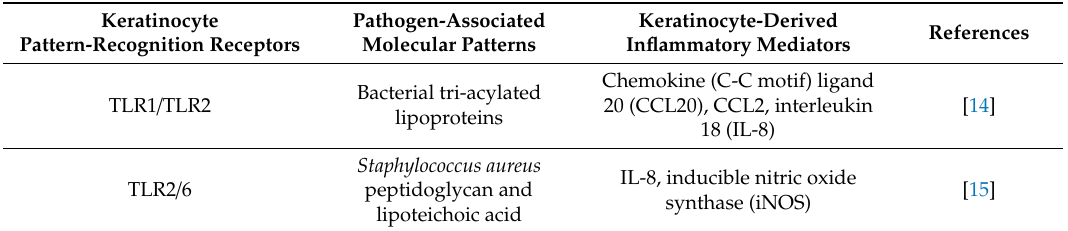
Table 1. Toll-like receptor (TLR)-mediated cytokine and chemokine expression in keratinocytes. Keratinocyte Pathogen-Associated Keratinocyte-Derived Pattern-Recognition Receptors Molecular Patterns Inflammatory